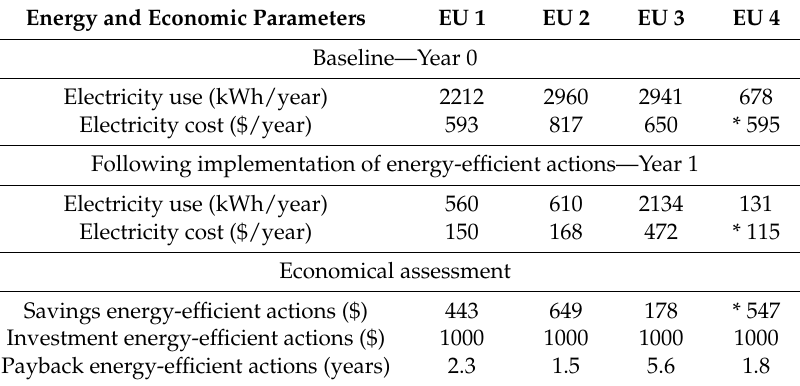
Table 5. Economical assessment of each